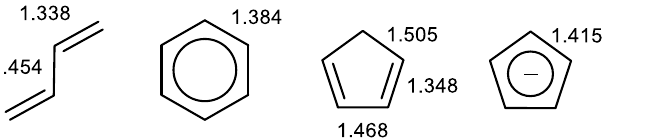
Figure 4. Bond lengths (in Å) in butadiene (experimental data) [37], benzene (D 6h symmetry, experi- mental data) [37], cyclopentadiene (B3LYP/6-311++G (d,p) results), and cyclopentadienyl anion (D 5h, B3LYP/6-311++G (d,p) results).